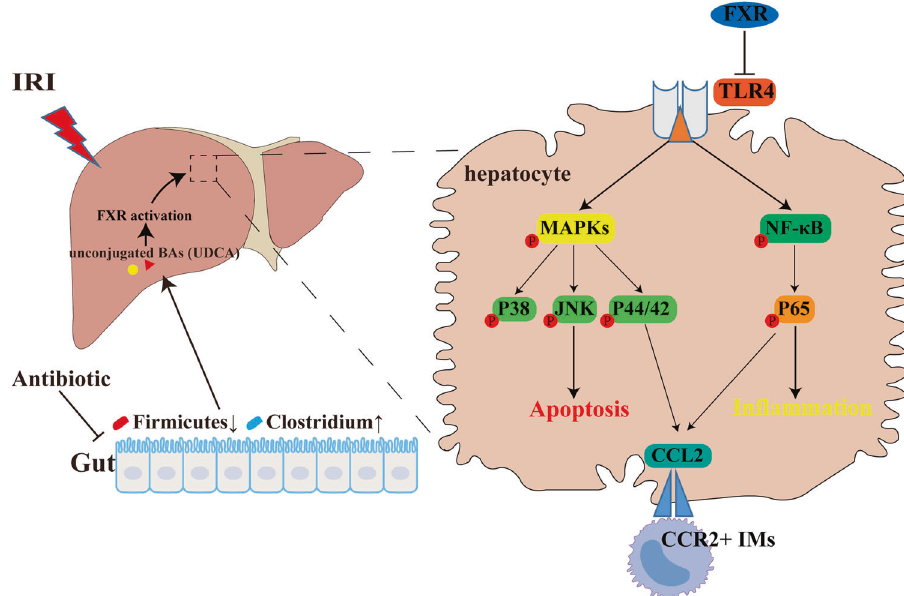
Fig. 8 Schematic summary of the present